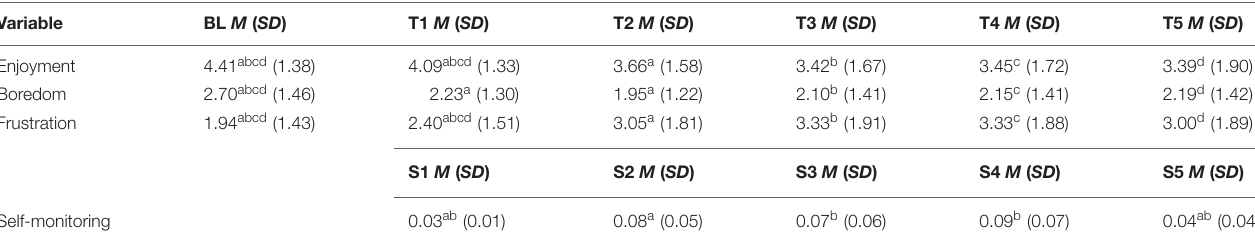
TABLE 1 | Means and standard deviations for single measurement occasions of learner-state variables. Variable BL M ( SD )